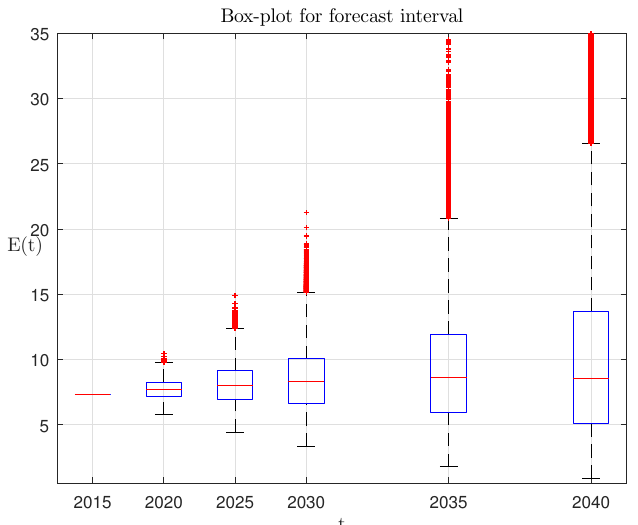
Figure 6. Box plot for the ensemble of projection trajectories on the testing